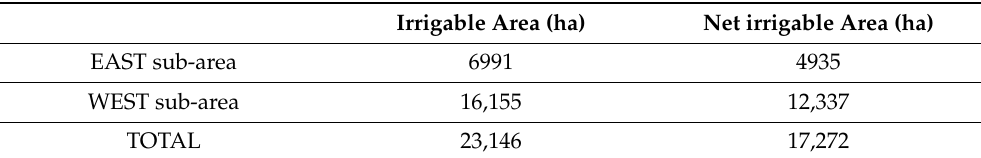
Table 3. Phases and sub-areas of the Chanza irrigable area.